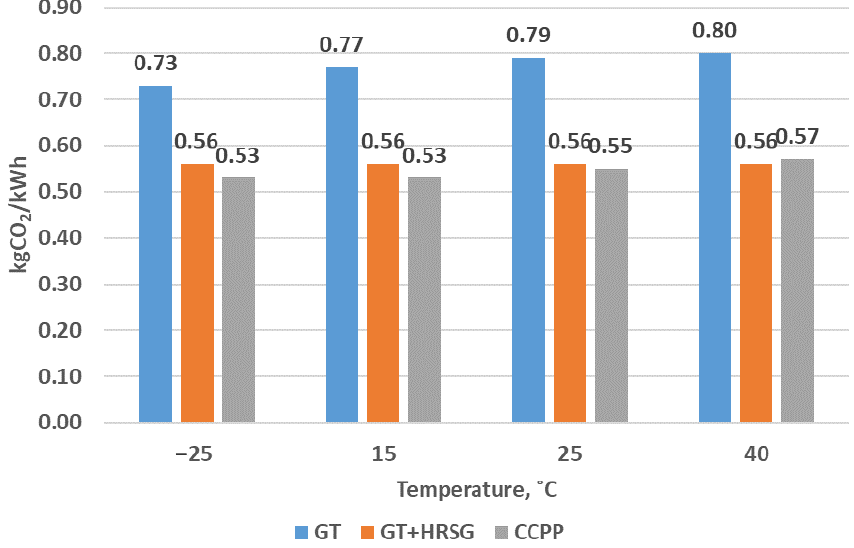
Figure 14. Specific CO 2 emissions per kWh of electricity produced.